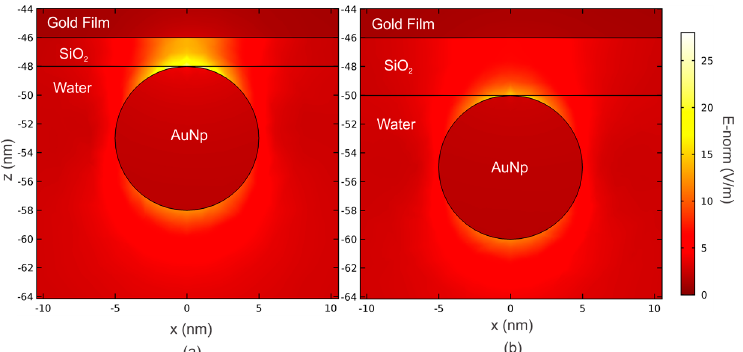
Figure 11. Norm of the near electric field surrounding the AuNPs for thin dielectric spacer layers: ( a ) h SiO2 = 2 nm and ( b ) h SiO2 = 4 nm. The parameters are λ = 633 nm, h Au = 46 nm, a = 5 nm, σ = 40 Np/µm 2 , and θ = 60°.